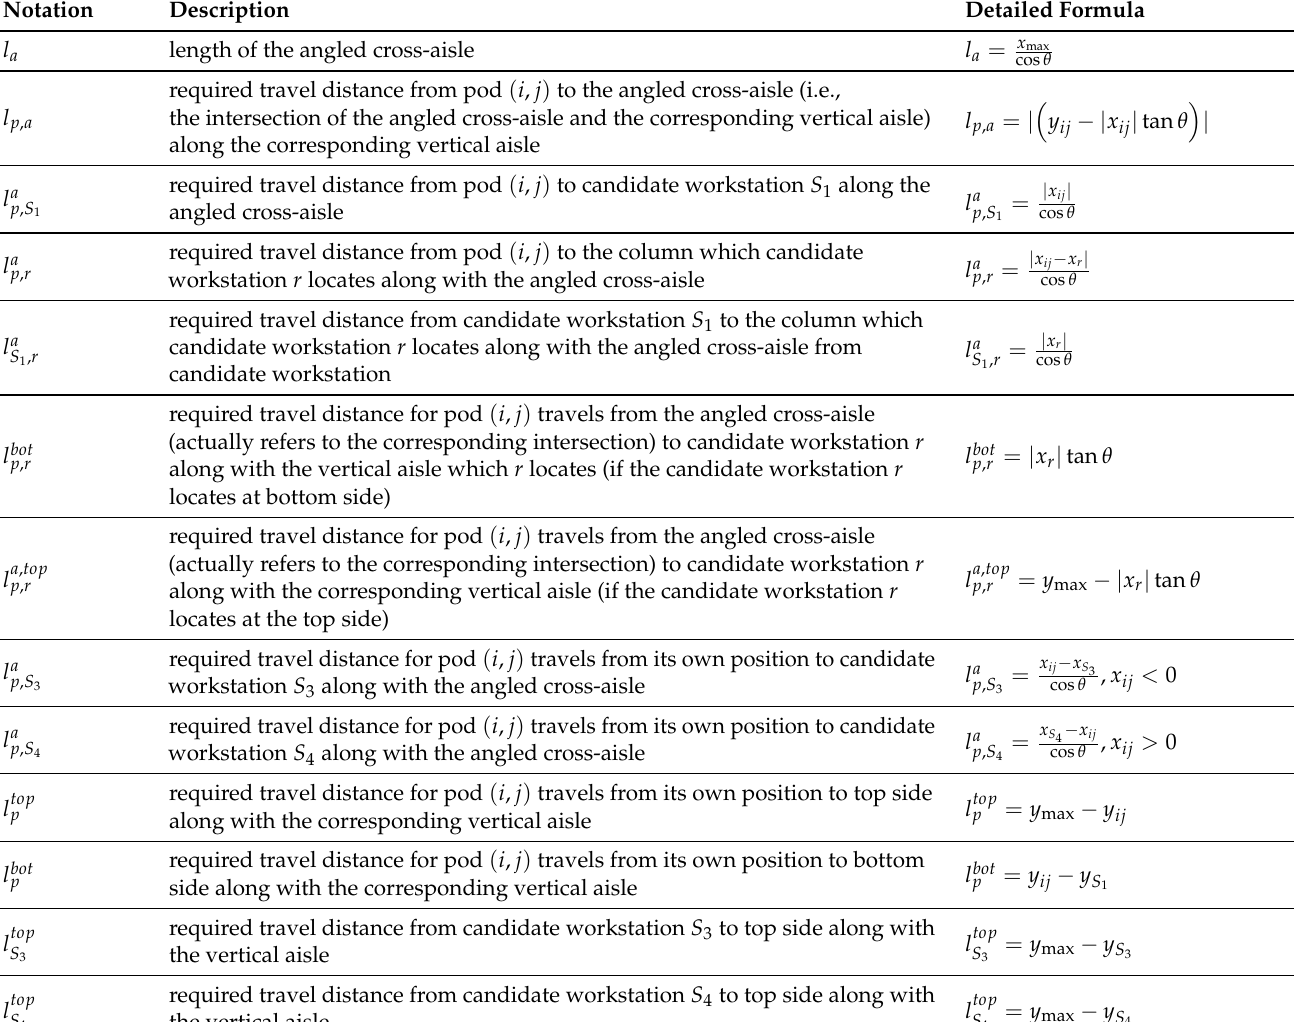
Table 2. Distance